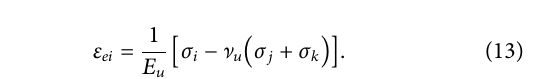
Frontiers in Earth Science |